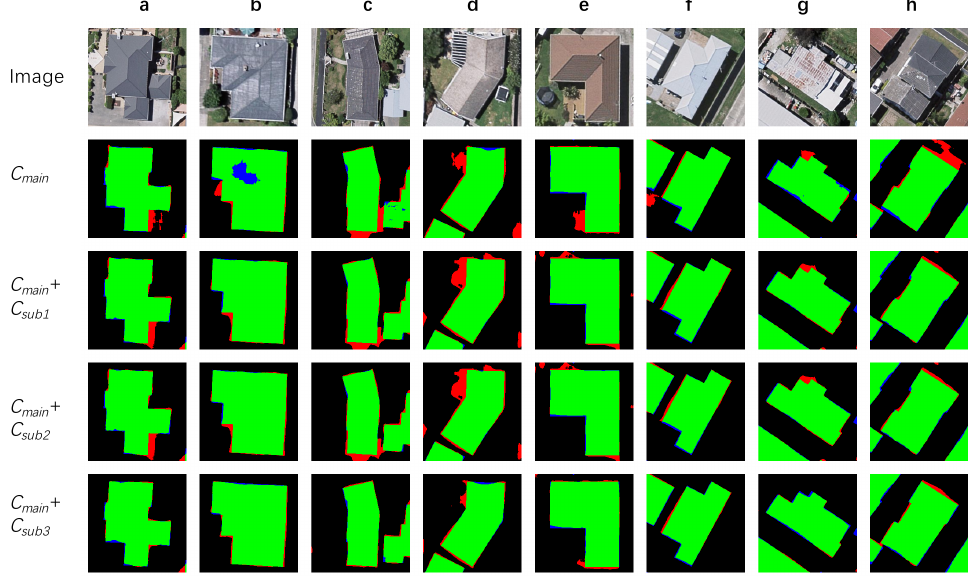
Figure 9. Representative results of segmented buildings from MC–FCN models with different constraint combinations. The green, red and blue channels of results represent true positive, false positive and false negative predictions, respectively, of every